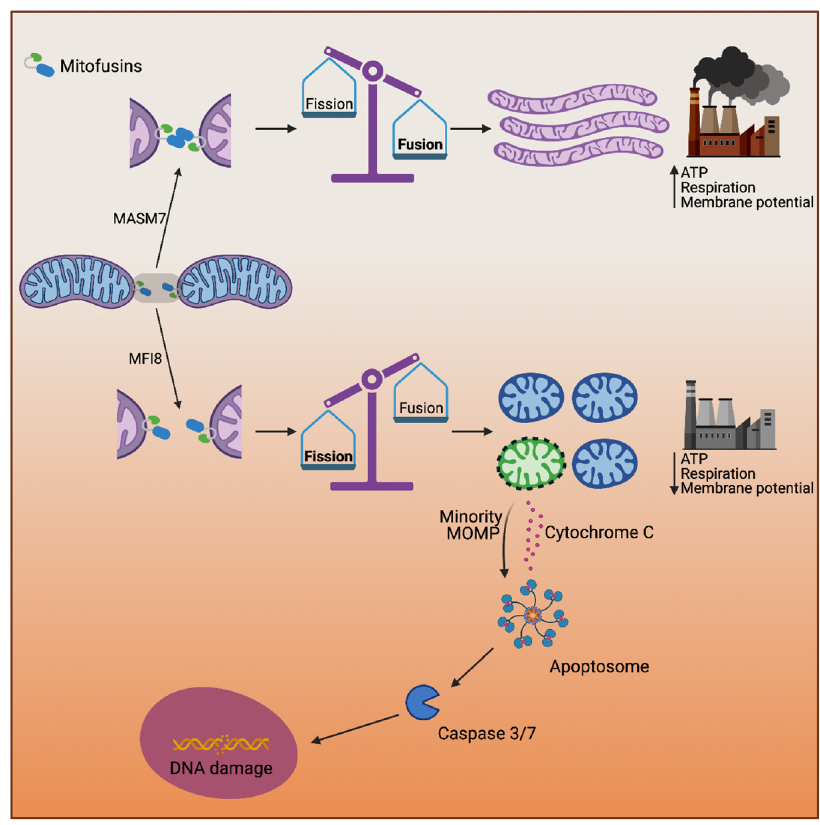
Fig. 8 Schematic representation of the mechanism of action of MASM7 and MFI8 and their effects in mitochondrial fusion, mitochondrial functionality, and signaling. The fi gure was created with